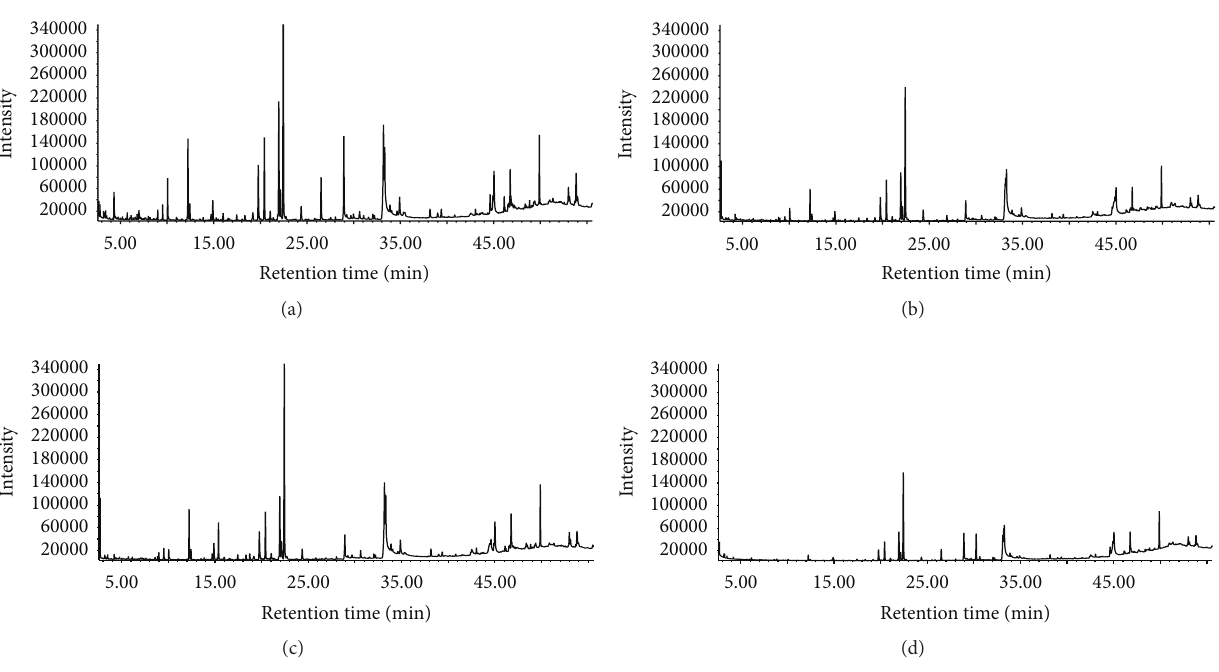
Figure 2: The total ion chromatogram (TIC) of ZTPs using different solvents and extraction methods: (a) ethyl acetate extraction by reflux method, (b) ethyl acetate extraction by ultrasonic wave, (c) ether extraction by ultrasonic wave, and (d) petroleum ether extraction by ultrasonic